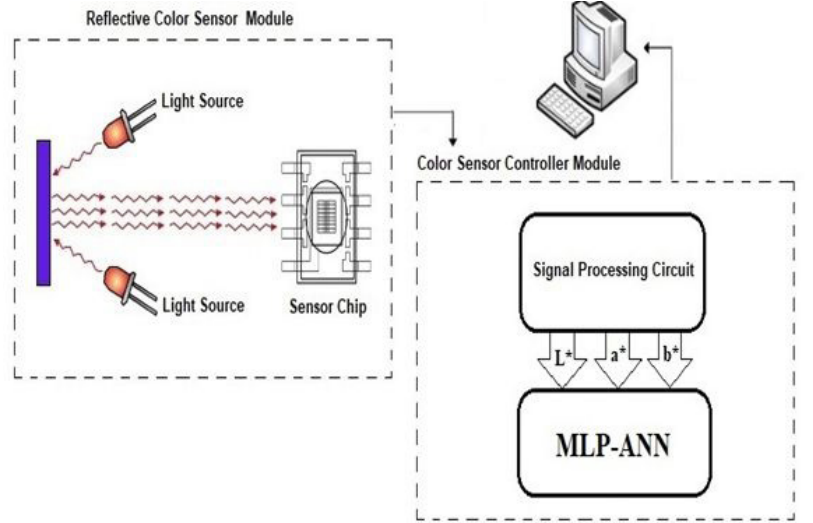
Figure 9. Reflectance mode circuit for monitoring the color transition of CoHo:PGLyD microspheres with temperature. Two D65 LED´s were used as light source and simulates the natural daylight. The sensor chip makes use of the TCS230-DB photodiode (PD). The output of the PD was amplified and applied to an 8051 microcontroller. The signal processing circuit converted the RGB values to CIEL * a * b * coordinates for the MLP-ANN